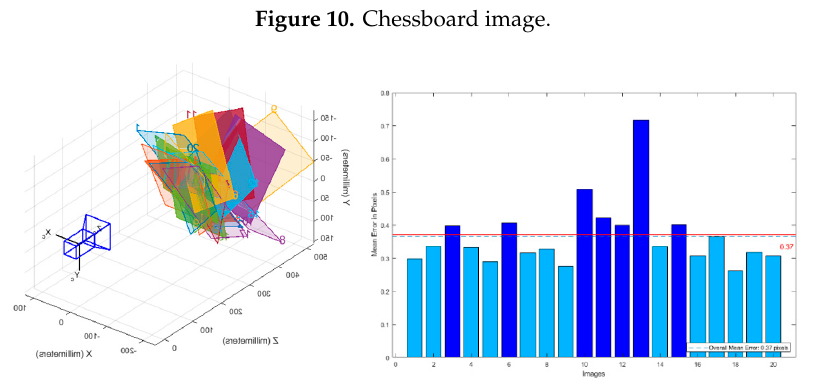
Figure 11. Calibration results.